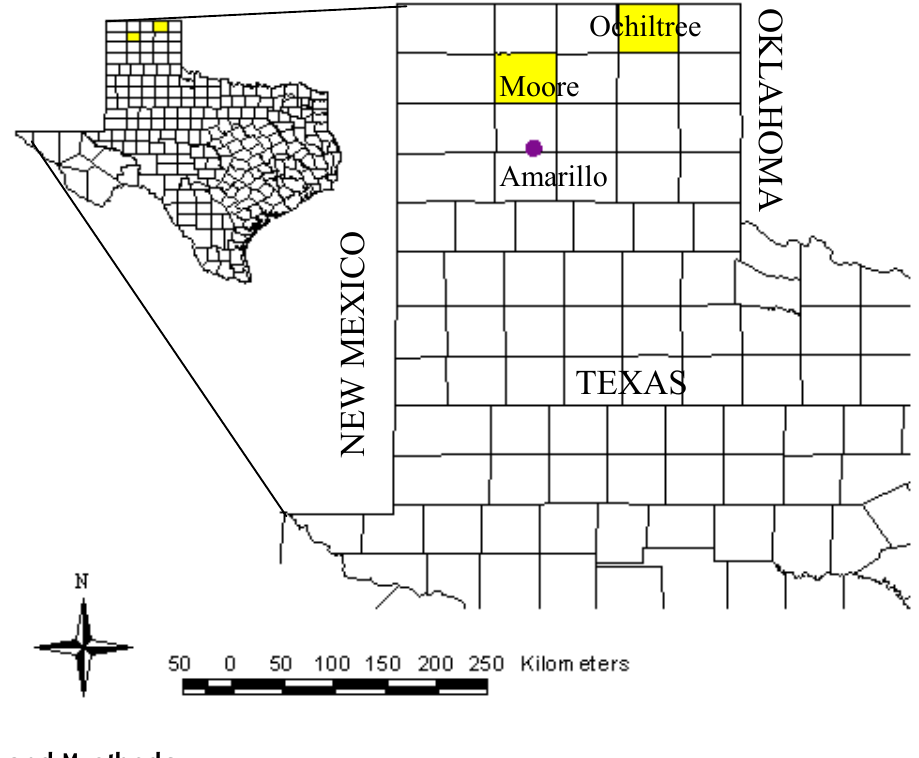
Figure 1. Location of Moore and Ochiltree Counties in the Texas High Plains,